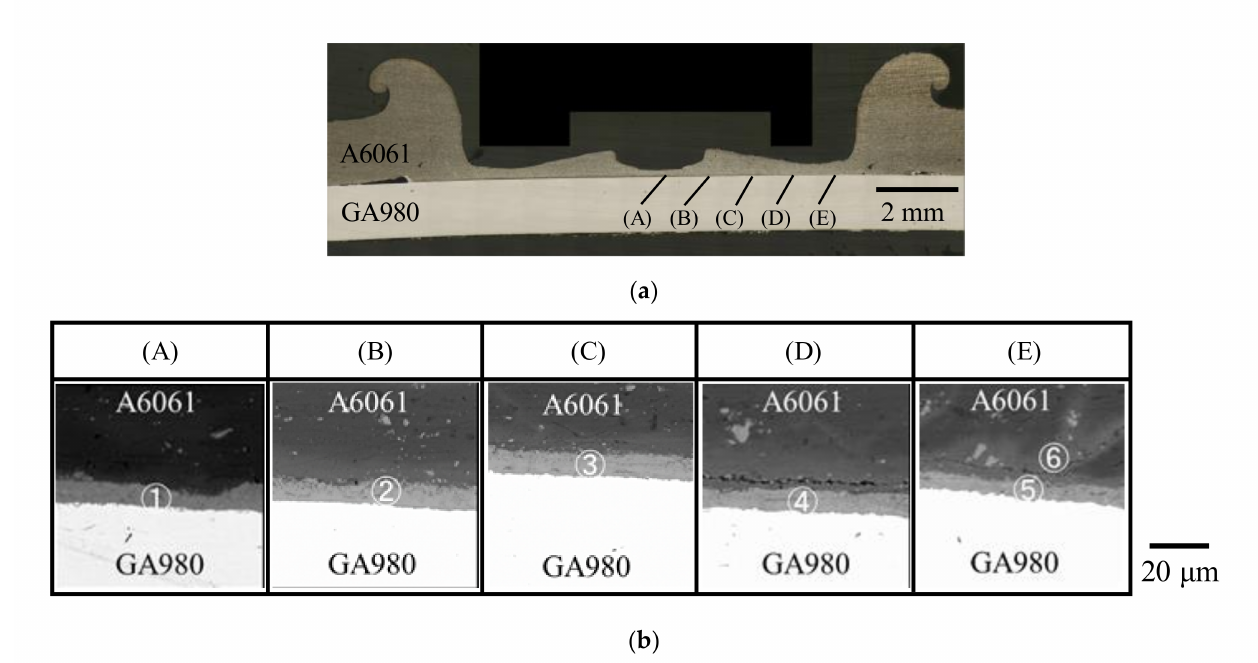
Figure 7. Microstructural observation result for the cross section of a joint using the laser microscope and the EPMA for the A6061/GA980 joint welded at welding time of 10 s. ( a ) Optical microscope image and analysis areas for EPMA analysis and ( b ) BSE images of the A6061/GA980 joint